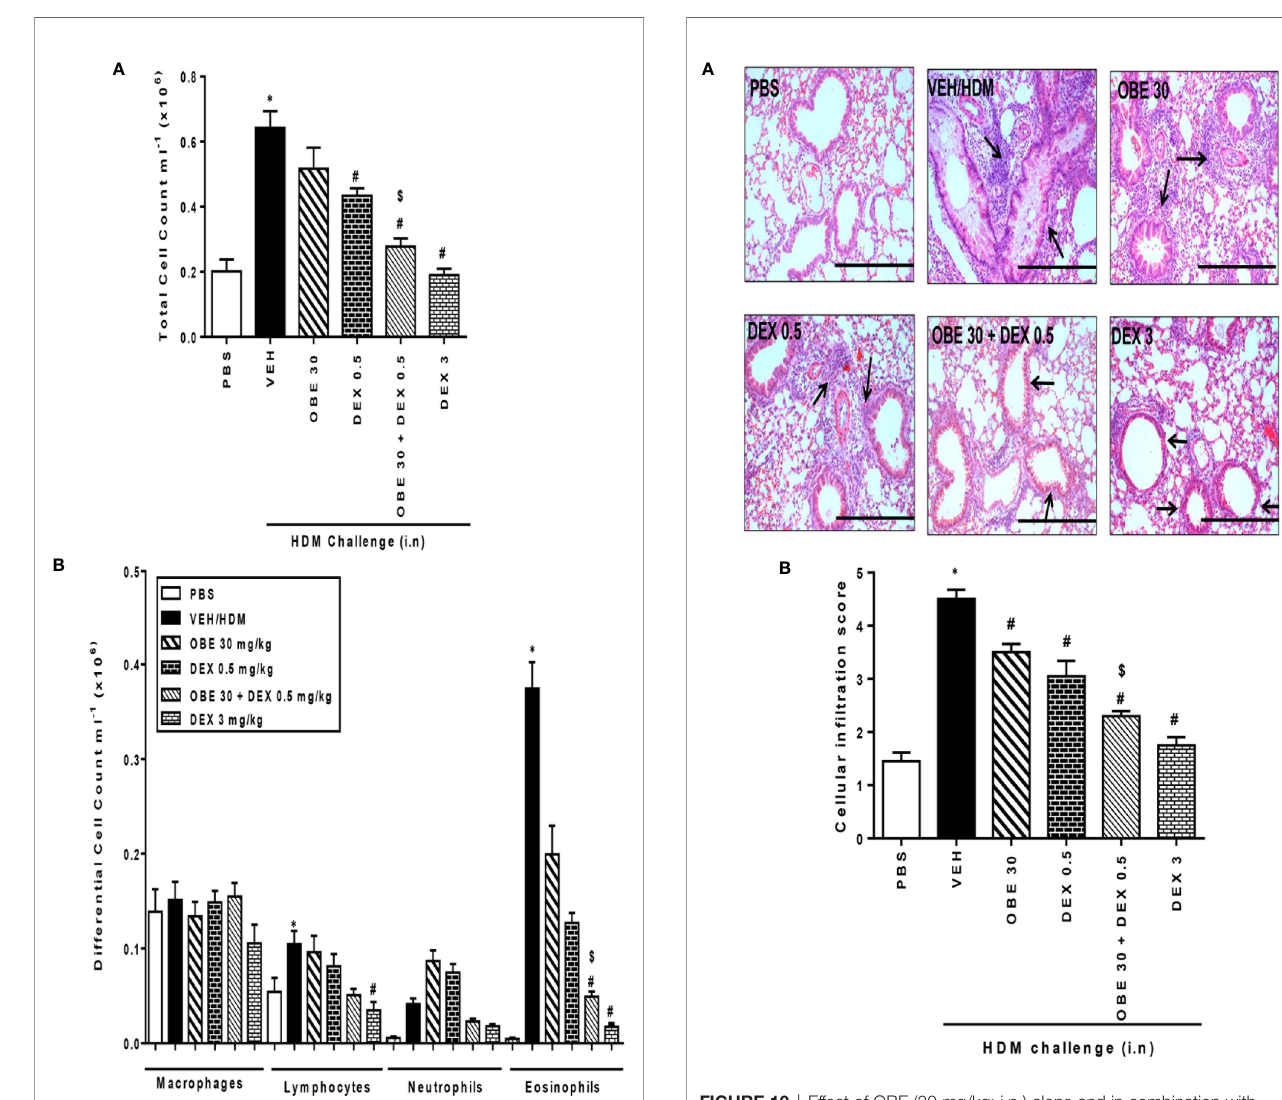
FIGURE 10 | Effect of OBE (30 mg/kg; i.p.) alone and in combination with low dexamethasone (0.5 mg/kg) on HDM-induced peribronchial and perivascular in fl ammatory cell in fi ltrations. (A) Representative low- magni fi cation light photomicrographs displaying H&E staining of whole lung samples from control PBS-challenged mice (PBS), HDM-challenged mice (HDM), HDM-challenged mice pretreated with OBE (30 mg/kg; i.p.) (OBE 30), HDM-challenged mice pretreated with low dexamethasone treated (0.5 mg/ kg; i.p.) (DEX 0.5), HDM-challenged mice pretreated with a combination of OBE (30 mg/kg; i.p.) and low dexamethasone treated (0.5 mg/kg; i.p.) (DEX 30 + DEX 0.5), HDM-challenged mice pretreated with high dose dexamethasone (3 mg/kg; i.p.) (DEX 3), scale bar = 200 µm. Graphs shows (B) cellular in fi ltration score for H&E. OBE treatment in combination with low dose dexamethasone resulted in a signi fi cant decrease in both peribronchial and perivascular in fl ammatory compared to either treatment when give alone. Data are expressed as mean ± SEM ( n = 5). *P < 0.05 vs PBS, # P < 0.05 vs HDM and $ P < 0.05 versus either OBE (30 mg/kg; i.p.) alone group or dexamethasone (0.5 mg/kg/i.p.) alone